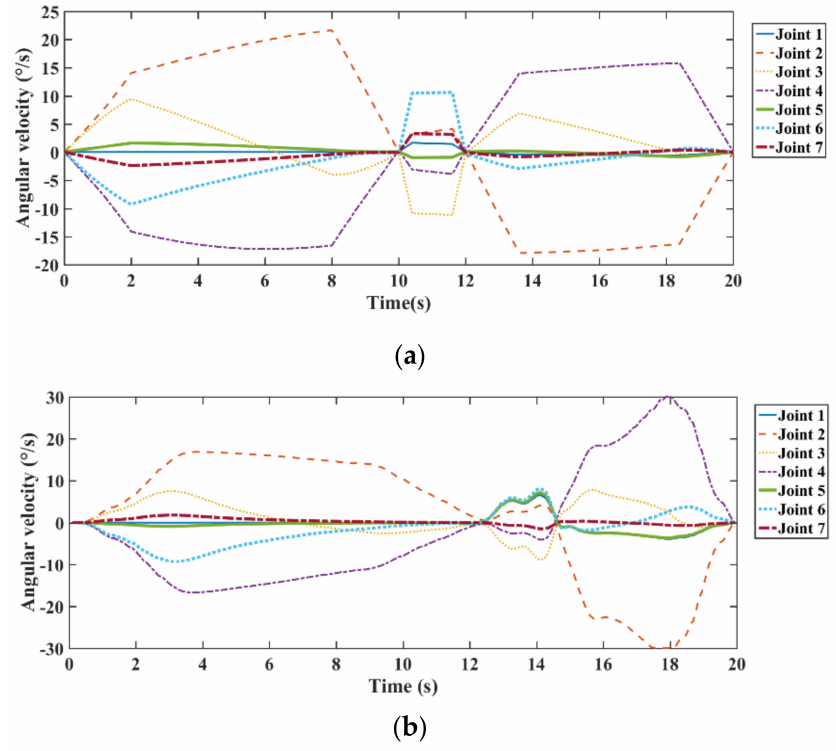
Figure 10. Joint angular velocity of trajectories. ( a ) Without optimization, ( b ) With